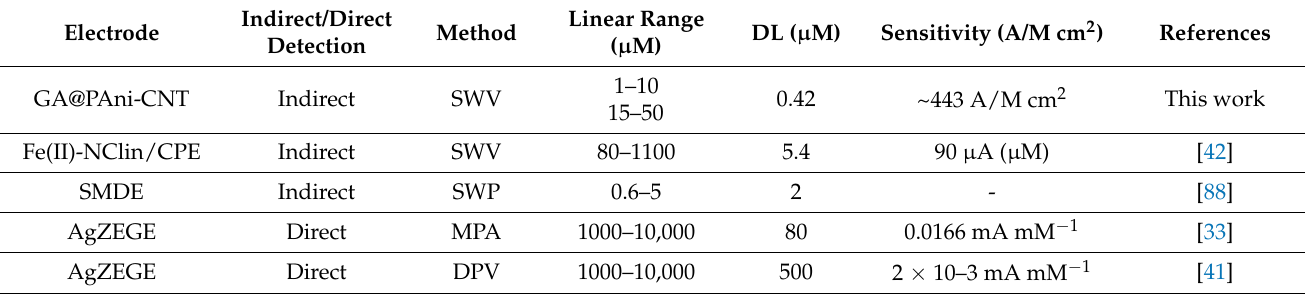
Table 1. Comparison of the analytical features of GA@PAni-CNT electrode with some of the reported works.